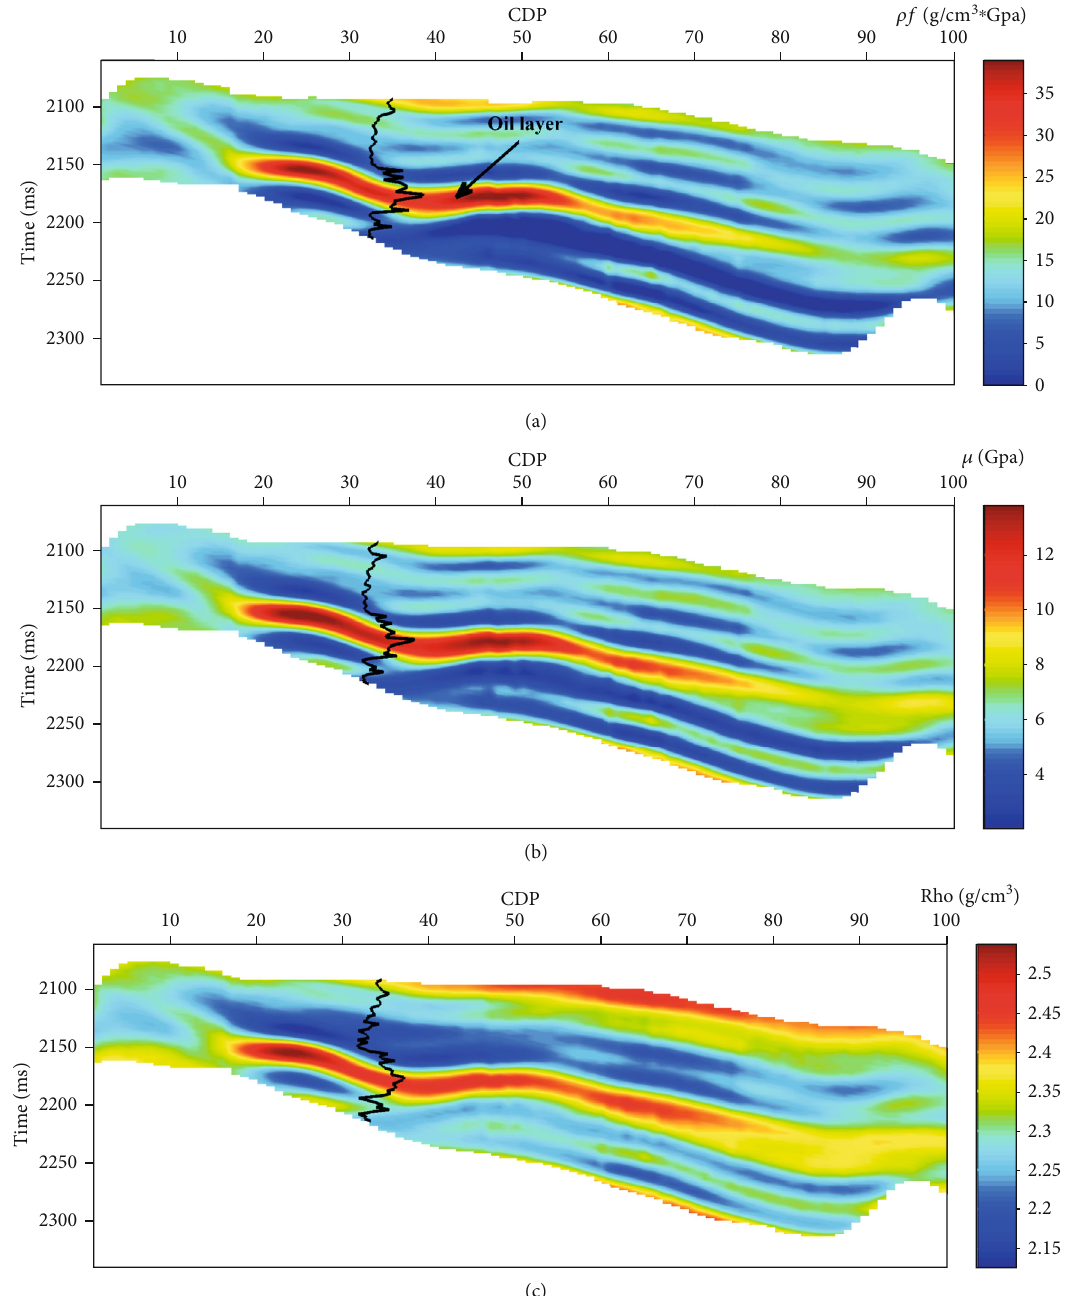
Figure 8: Field data inversion results: (a) fl uid factor, (b) shear modulus, and (c) density. The black curve indicates the real logging data of Well A, and the arrow indicates the target